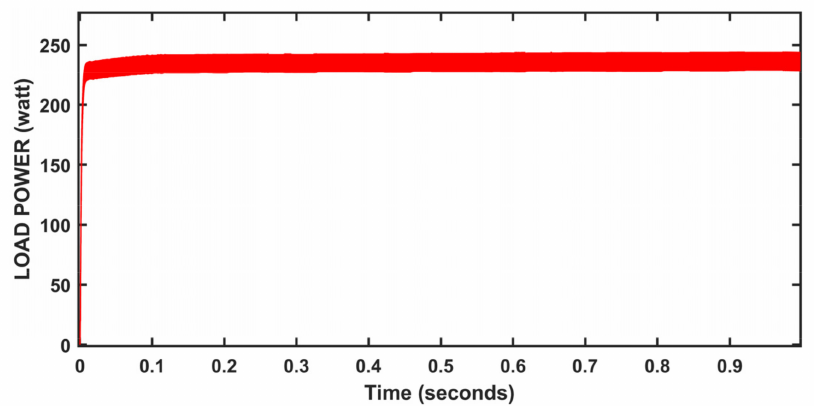
Figure 40. Performances at constant irradiance, temperature, and